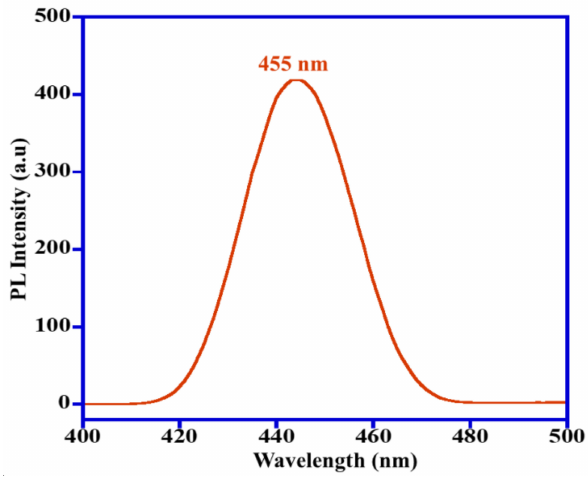
Figure 7. Photoluminescent spectra indicating generation of • OH radicals by Mn 3 O 4 /ZnO/Eu 2 O 3